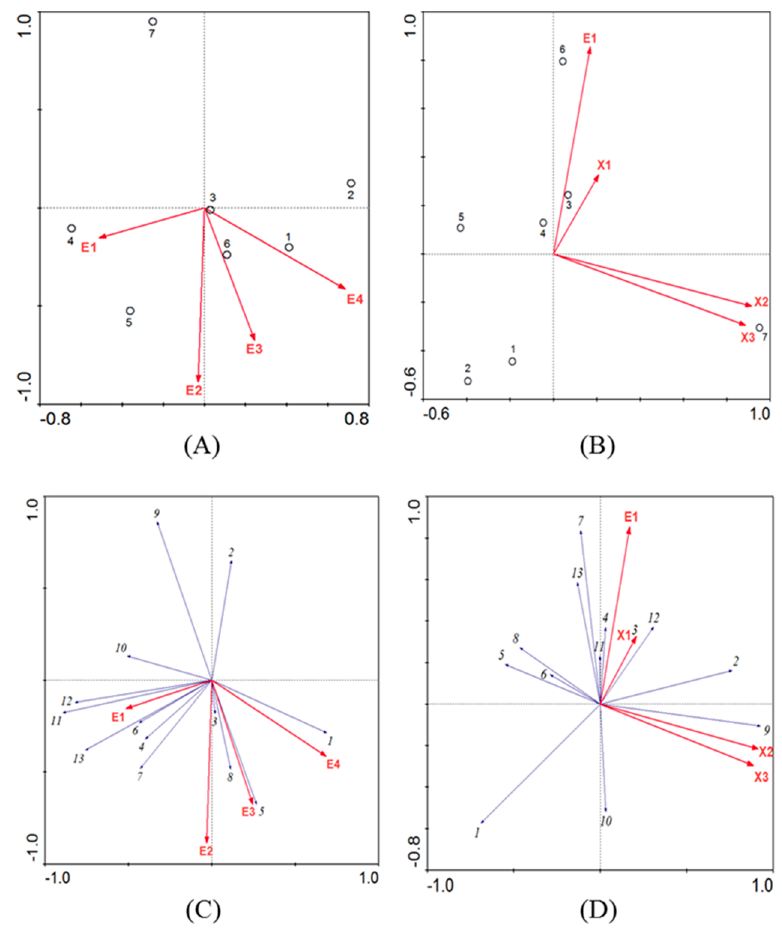
Figure 5. Correlations between microbial community structure of the anammox sludge with ( A ) environmental factors and ( B ) nitrogen removal rate and between microbial community structure based on the denaturing gradient gel electrophoresis bands with ( C ) environmental factors and ( D ) nitrogen removal rate. The black numbers in (A, B) refer to the experimental reactors: 1, (Ca 2 + ) = 25 mg / L; 2, (Ca 2 + ) = 50 mg / L; 3, (Ca 2 + ) = 75 mg / L; 4, (Ca 2 + ) = 80 mg / L; 5, (Ca 2 + ) = 100 mg / L; 6, (Ca 2 + ) = 125 mg / L; 7, initial sludge. The black numbers in (C, D) refer to the band numbers in Figure 3. E1, Ca 2 + concentration; E2, total nitrogen content; E3, NH 4 + –N content; E4, NO 2 − –N content; X1, NO 2 − –N removal rate; X2, NH 4 + –N removal rate; X3, TN removal rate.